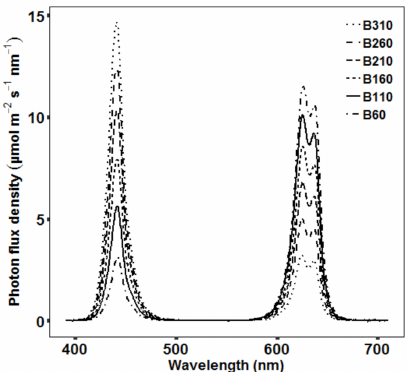
Figure 6. The measured spectrum of the six treatments with a BPFD of 60, 110, 160, 210, 260 and 310 µ mol m − 2 s − 1